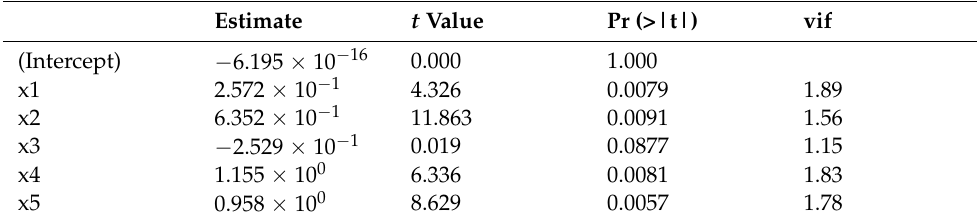
Table 10. Regression results of optimized